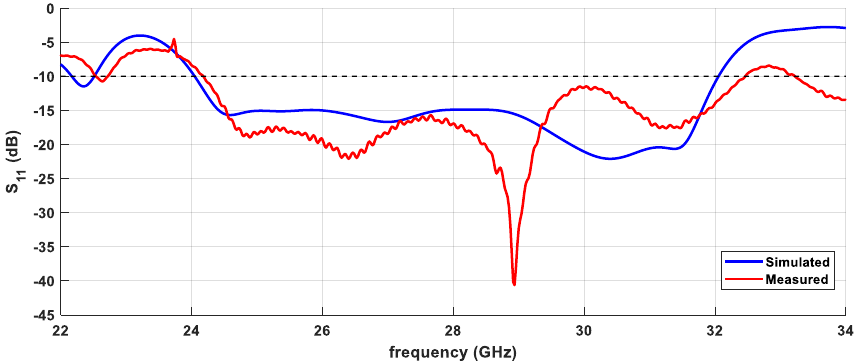
Figure 8. Simulated and measured reflection coefficient of the 7 elements antenna array.